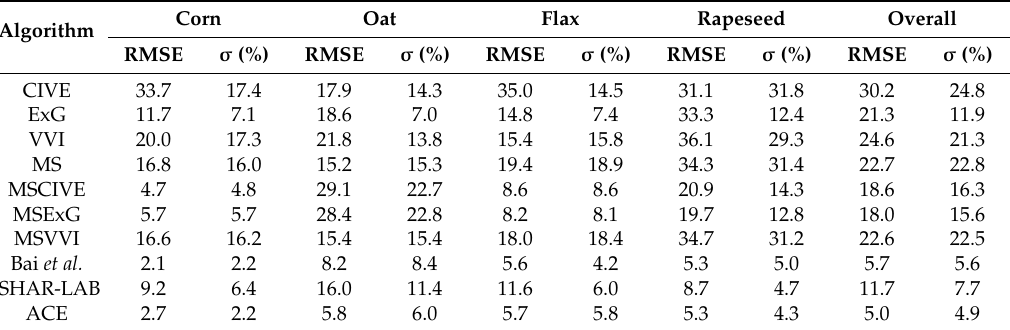
Table 2. RMSE and standard deviation of difference between estimated FVC values and the ground truth FVC values for the ten algorithms evaluated.